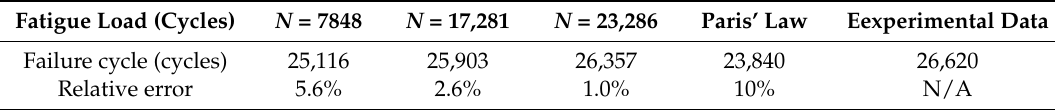
Table 5. The estimation of the failure cycle for the specimen T 5 .